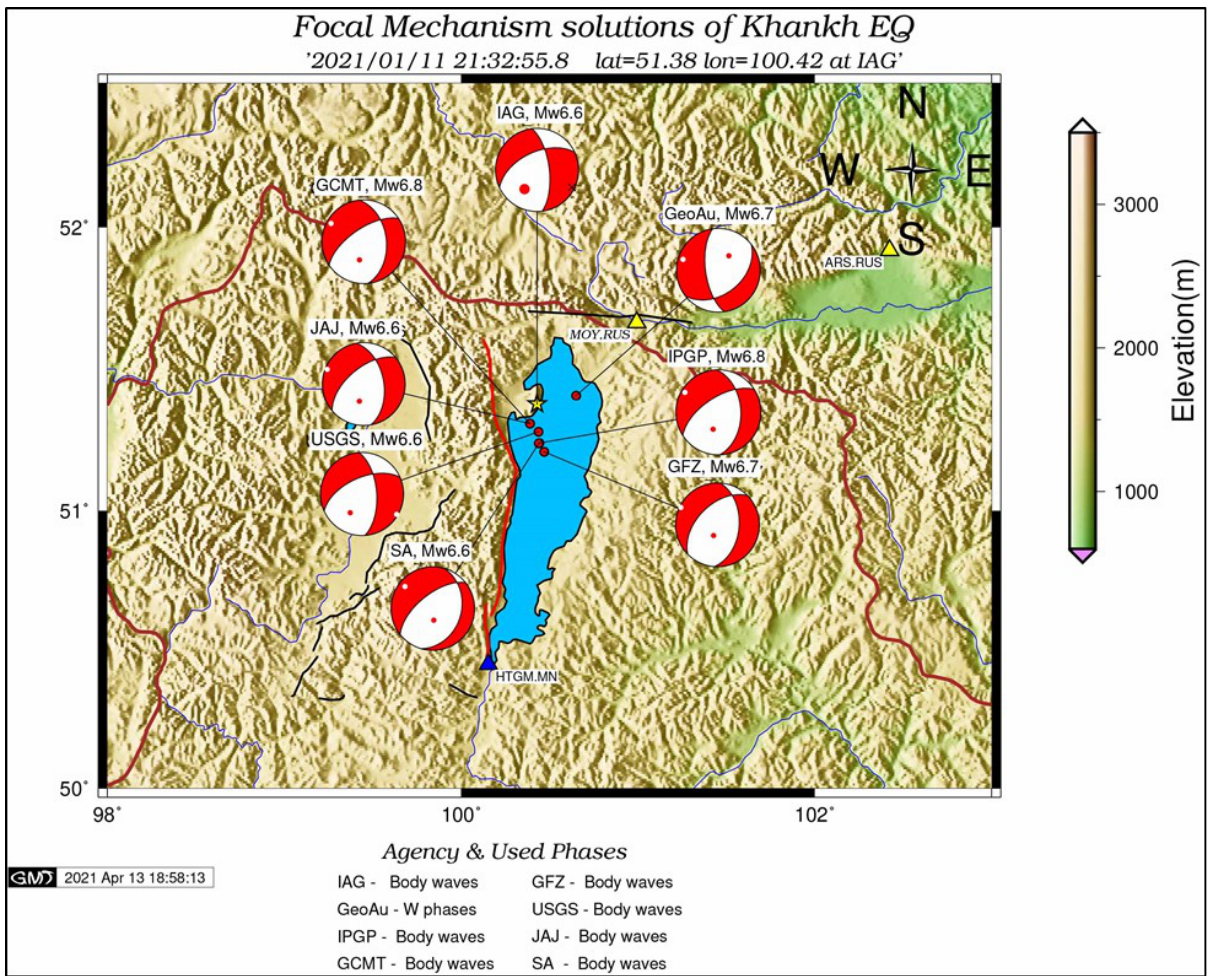
Fig. A2. The focal mechanism solutions are modified and plotted by Generic Mapping Tools (Wessel et al., 2013). The fault plane solutions of USGS, GCMT, GeoAu, IPGP and GFZ are from the web-based open-source data. JAJ and SA are from the personal communications. The fault plane solution of IAG was determined in the Mongolian National Data Center. All focal mechanisms were estimated with moment magnitude (M show the locations of the Russian local seismic stations. The blue triangle shows the location of the Mongolian local seismic